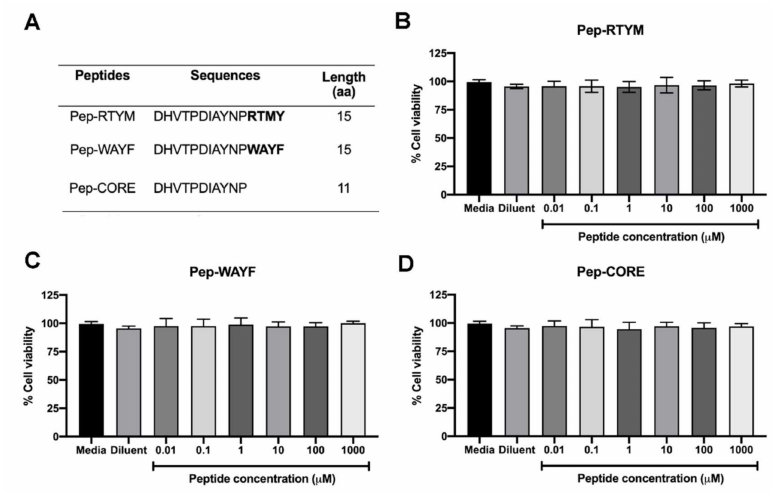
Figure 1. Cytotoxicity of bioactive peptide inhibitors. Three bioactive peptides derived from Acacia catechu were determined for their toxicity to Vero cells ( A ). Cell viability after 48 h treatment of Pep-RTYM ( B ), Pep-WAYF ( C ), and Pep-CORE ( D ) was represented as percentage (%) of cell viability relative to that of non-treatment control, which was set as 100% cell